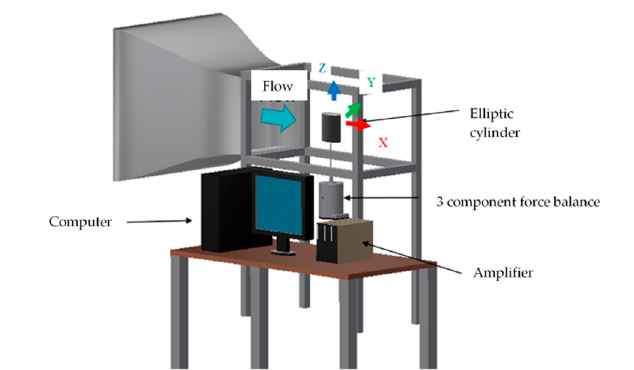
Figure 3. Schematic diagram of test section and force balance system.